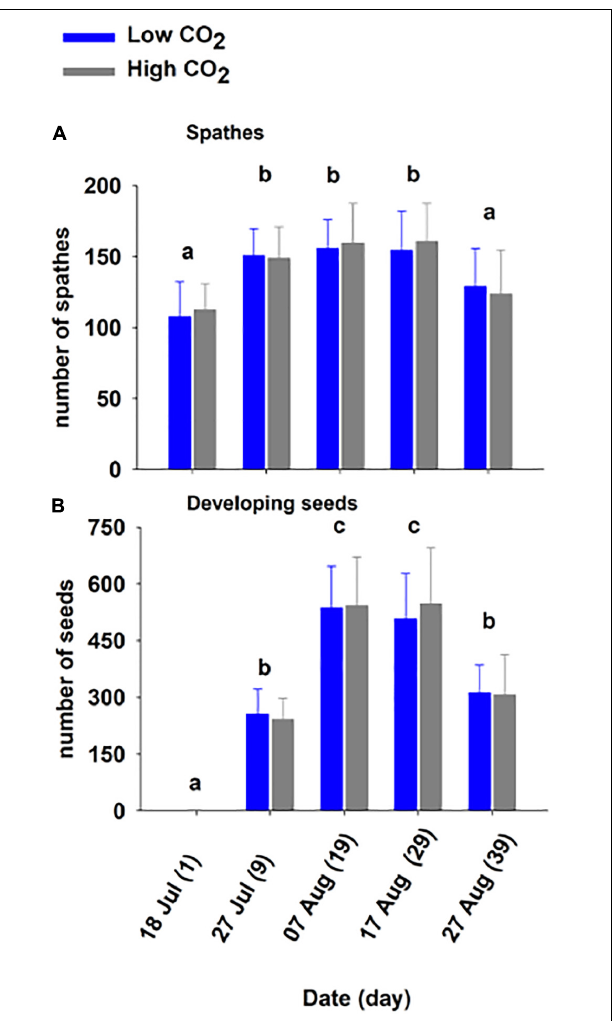
FIGURE 3 | Mean ( ± SD) spathes (A) and seed number (B) on shoots held at low and high CO 2 condition for 39 days (Experiment 1). The different letters above bars represents statistical differences between time as specified by the results of a Holm–Sidak pairwise comparison test following a repeated measure two-way ANOVA, Table 2